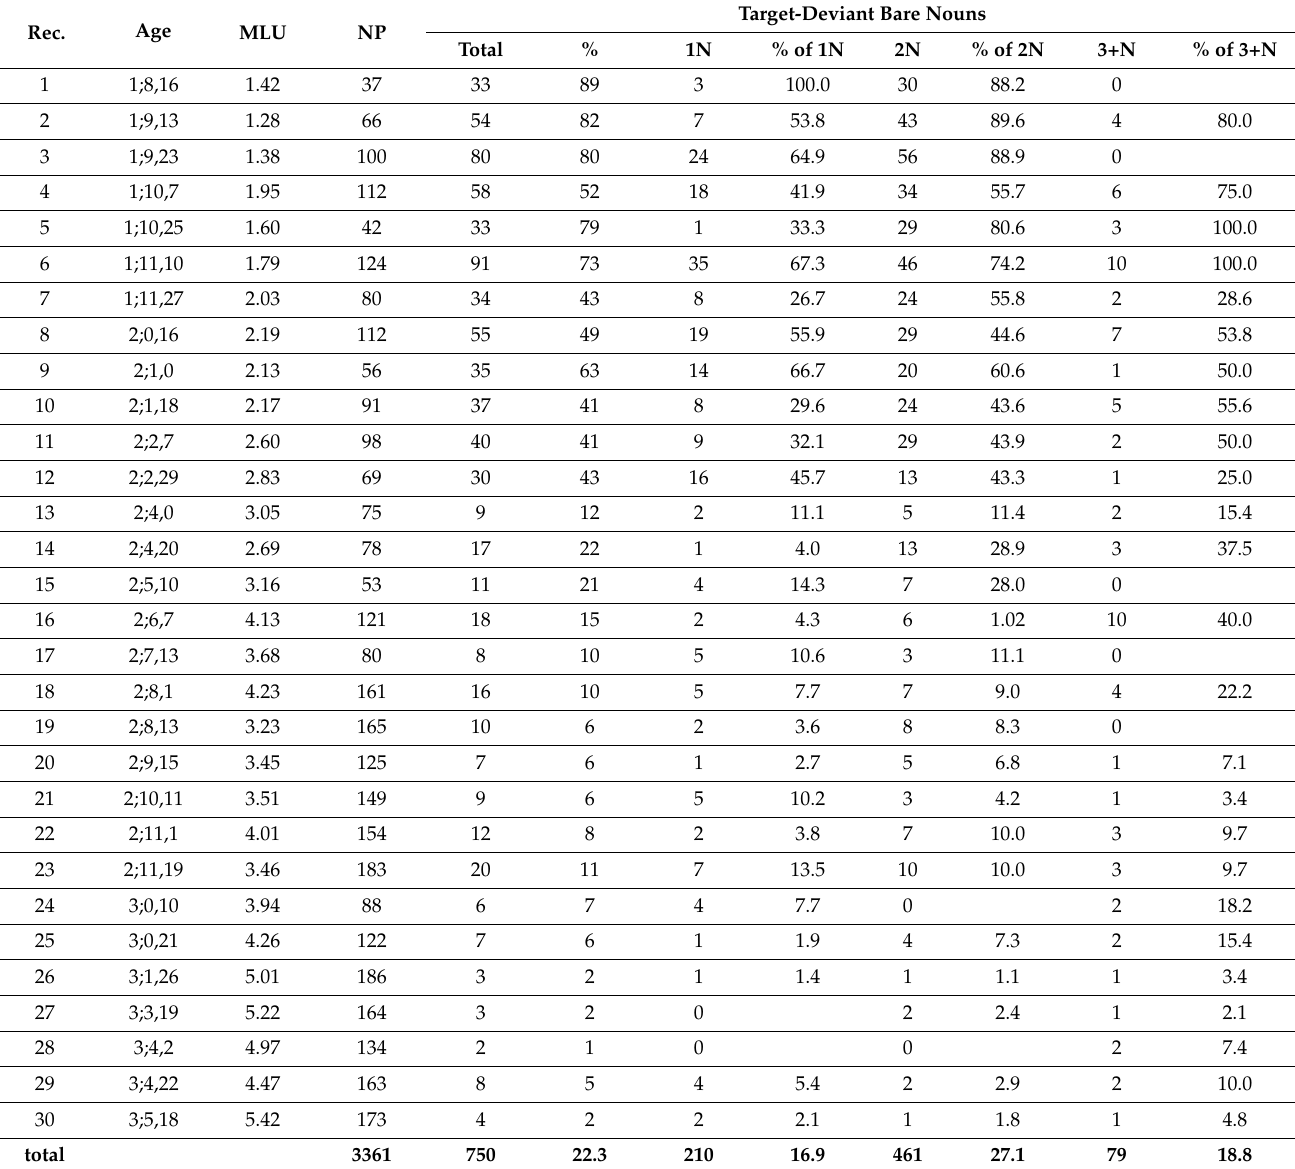
Table A1. Ju_fi: Target-deviant bare nouns per